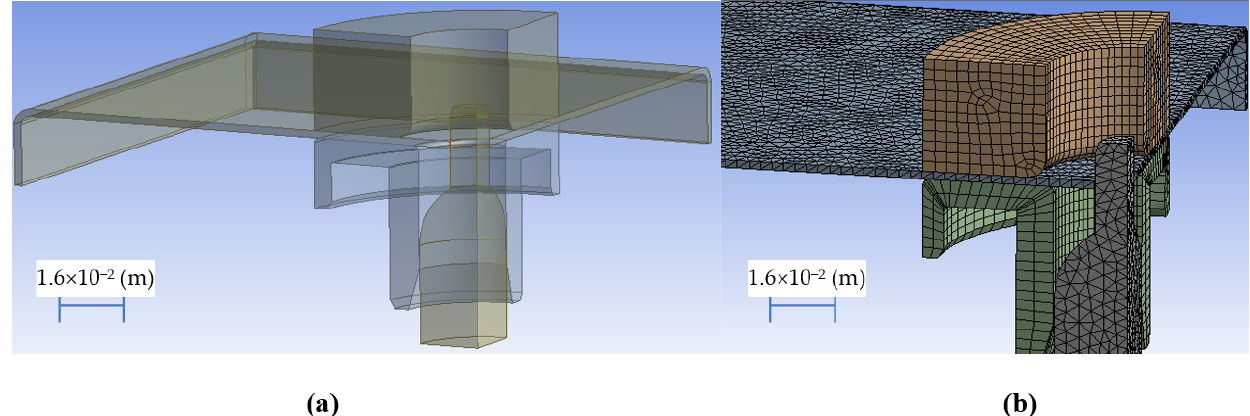
Figure 7. Geometric model ( a ) and discrete model ( b ) during the flange forming process-radial stretching of the hole.